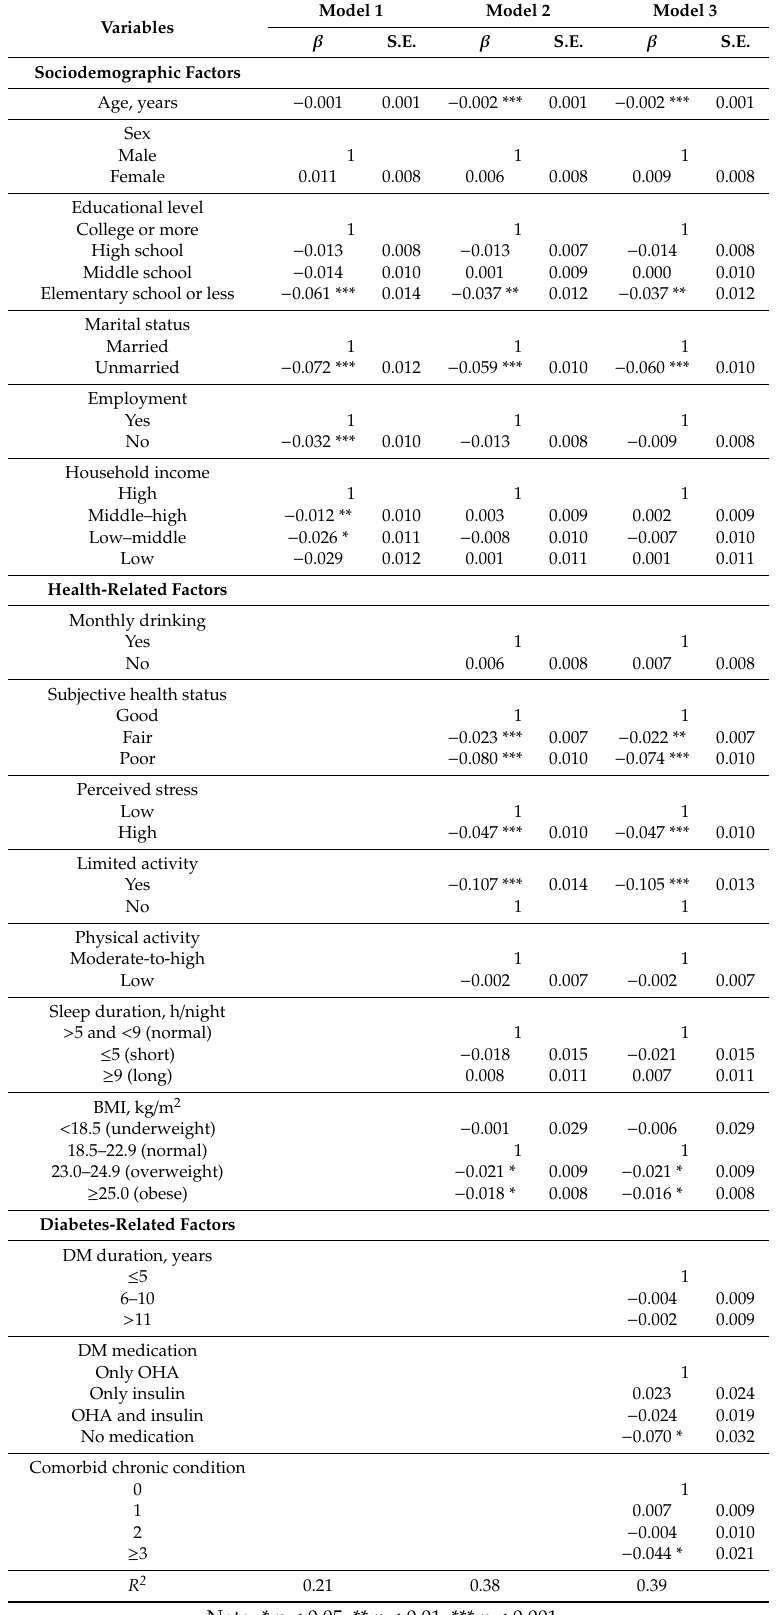
Table 3. Complex-sample general linear regression analyses predicting HRQoL in people with DM ( n =